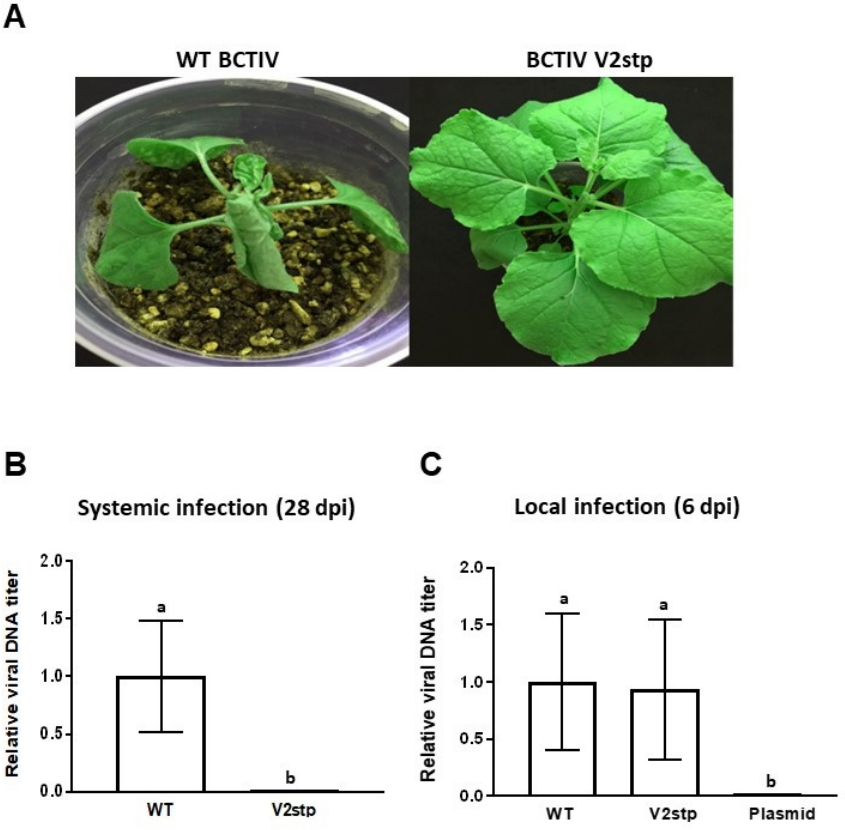
Figure 6. Infection of wild type Nicotiana benthamaiana plants with wild type beet curly top Iran virus and the V2 stop mutant virus. Plants were agroinoculated with wild-type (wt BCTIV) or V2 mutant BCTIV (BCTIV V2stp) infectious clones. ( A ) Representative plants showing BCTIV symptoms at 28 dpi. Relative viral DNA accumulation in apical leaves (systemic infection) at 28 dpi ( B ) or in the infiltrated leaves (local infection) at 6 dpi ( C ). BCTIV accumulation was measured by qPCR after DpnI treatment to remove bacterial DNA (6 dpi). The same DpnI treatment was applied on bacterial plasmids containing the BCTIV infectious clone as a control (Plasmid). DNA levels were normalized to Elongation factor alpha ( NbE1Fa ) and are presented as the relative amount of virus compared with the amount found in wild-type BCTIV samples (set to 1). Bars represent mean values ± standard error (SE) for six pools of two leaves. Mean values marked with different letters (a or b) indicate results significantly different from each other, as established by Student’s t-test α < 0.001) virus titer. To determine if the absence of symptoms correlated with an absence of viral DNA, total DNA was extracted from the newly emerging leaves of the inoculated plants at 28 dpi, and viral DNA was quantified by quantitative real-time PCR (qPCR). No BCTIV DNA was detected in the apical leaves of plants inoculated with V2 mutant BCTIV (Figure 6B), indicating that V2 mutant BCTIV could not infect plants systemically. To test if V2 is required for viral replication, we performed a local infection assay. Total DNA was extracted at 6 dpi from the infiltrated leaves, and viral DNA was quantified by qPCR. No differences in the amount of viral DNA accumulated in the infected tissues were detected in the leaves infected by wt BCTIV or V2 mutant BCTIV (BCTV-V2stp) (Figure 6C). This result showed that BCTIV V2 is not required for viral replication and points to a role in viral movement, as it has been described for other V2 proteins. However, considering that the mutation also affects V3, we cannot exclude the possibility that the lack of movement in the systemic infection is not only due to the mutation in V2.